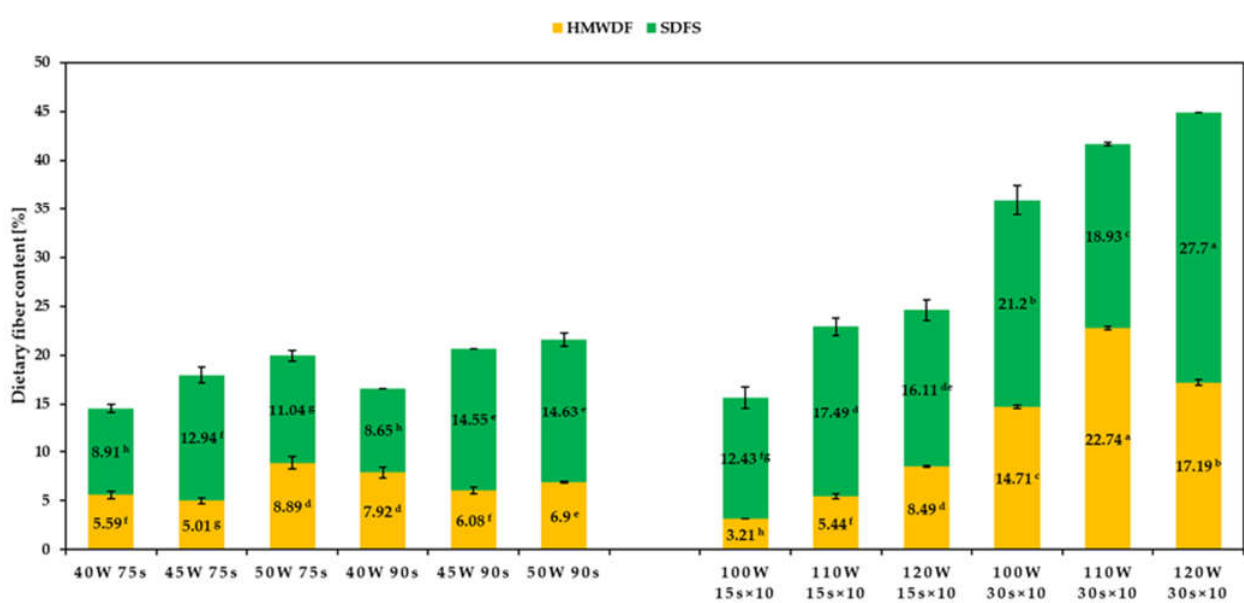
Figure 4. Dietary fiber content of dextrins prepared by continuous ( left ) and discontinuous ( right ) microwave-assisted heating. Different superscript lowercase letters (a, b, . . . ) in the same column indicate significant differences ( p < 0.05) between each parameter for each dextrin.